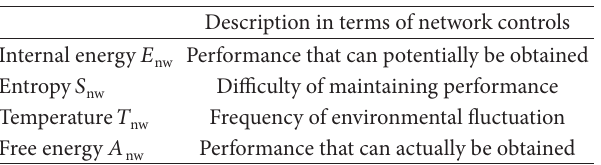
Table 2: Interpretation from the perspective of network controls. Description in terms of network